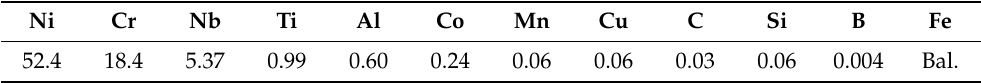
Table 1. Chemical composition of superalloy 718